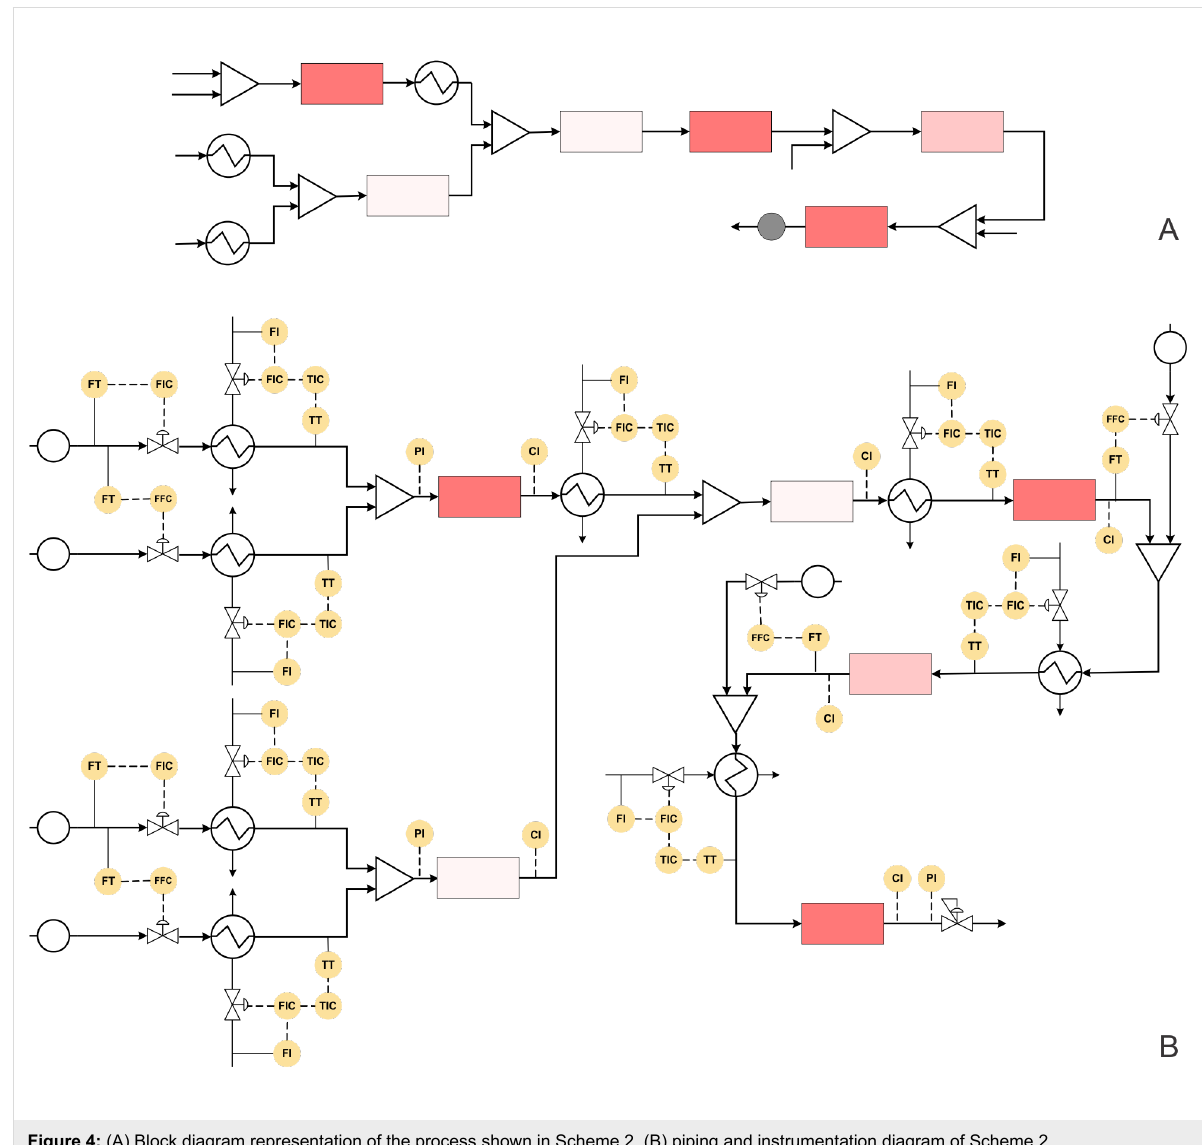
Figure 4: (A) Block diagram representation of the process shown in Scheme 2, (B) piping and instrumentation diagram of Scheme 2.